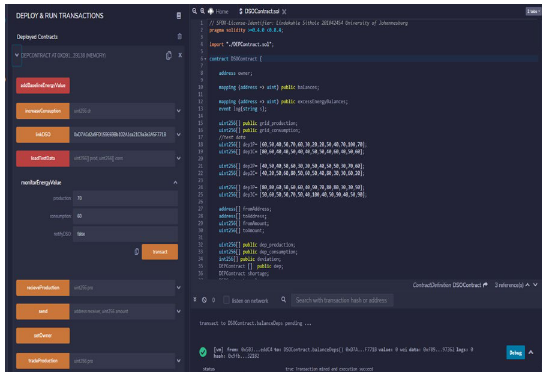
Fig. 5 Energy monitoring using the IoT